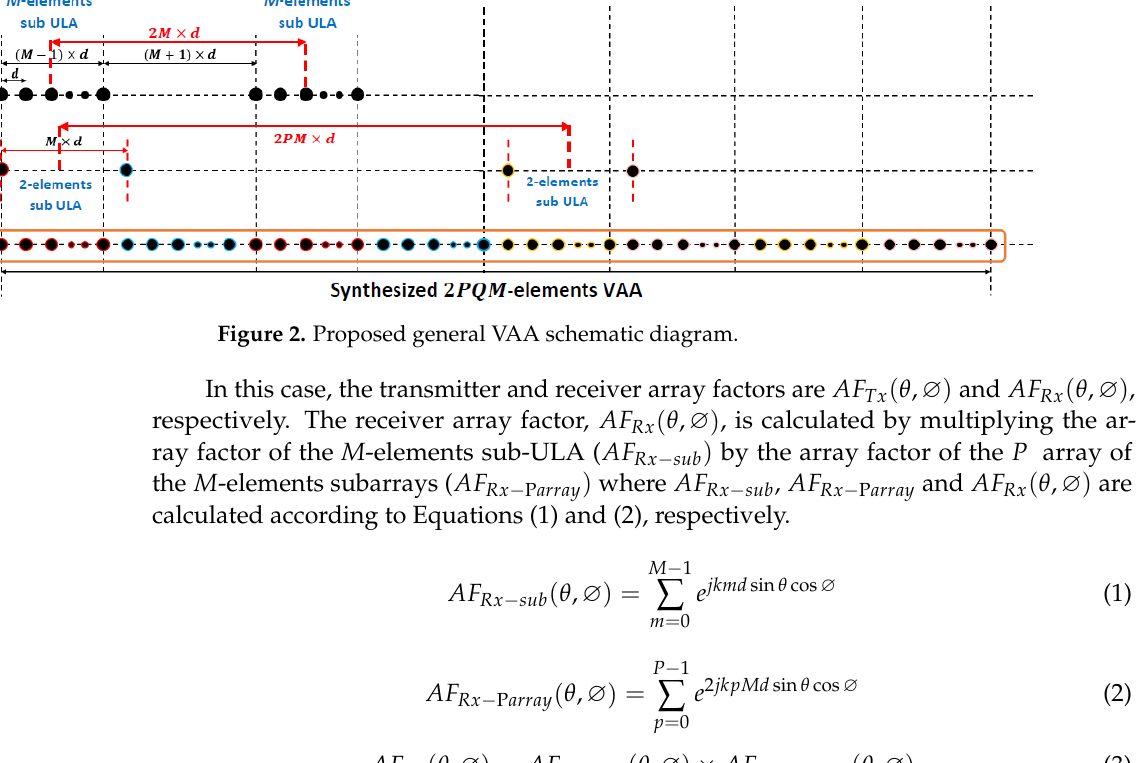
Figure 1. A schematic diagram of the general radar system.